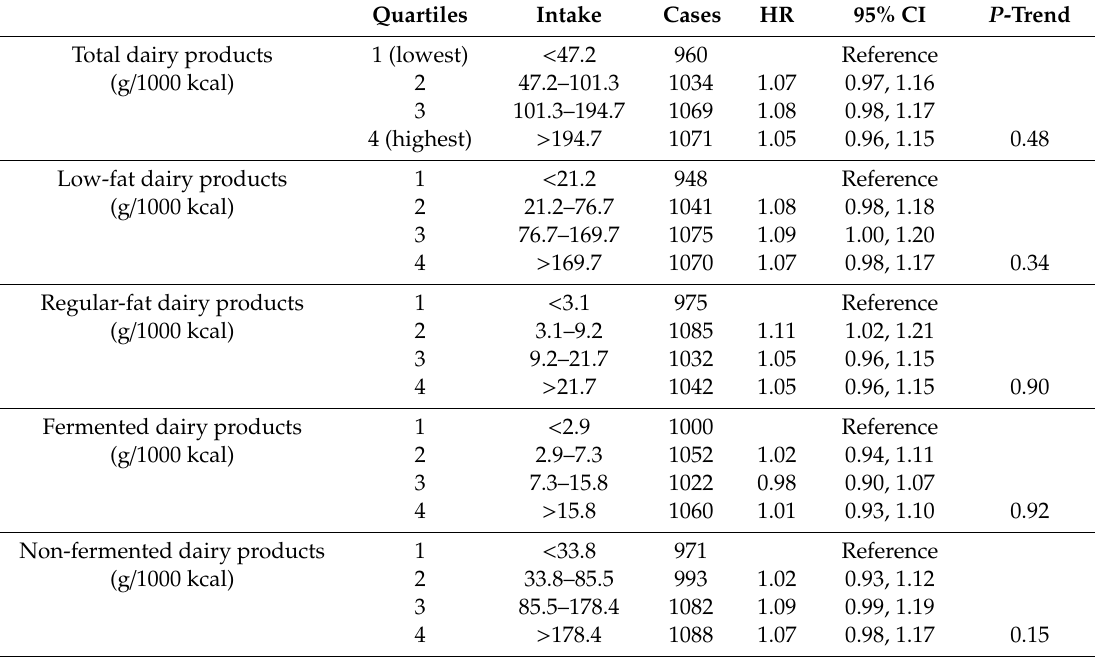
Table 2. Risk of prostate cancer by quartiles of dairy product intakes *.